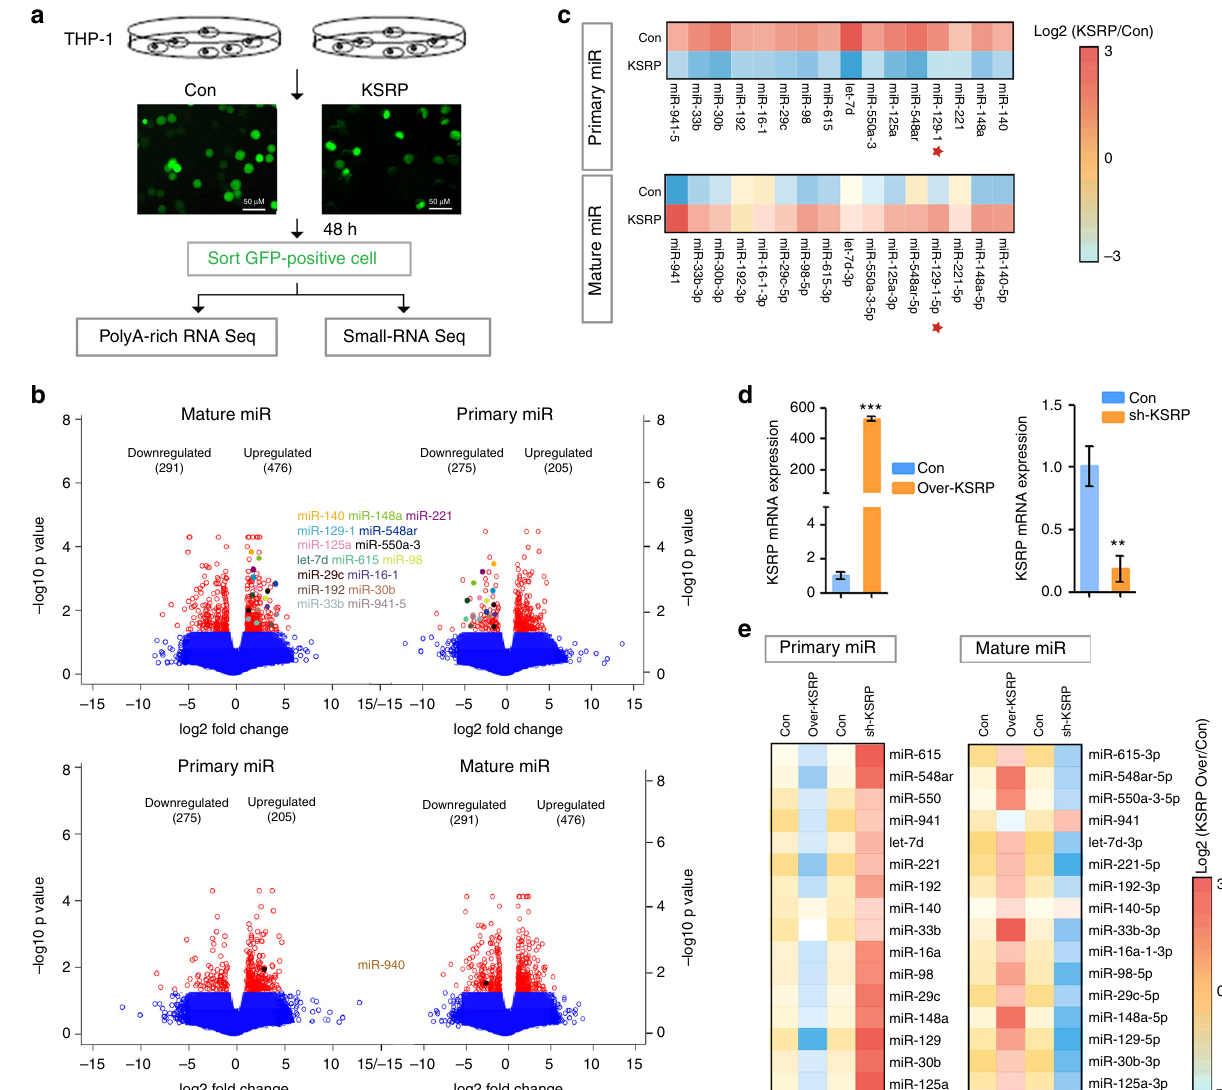
Fig. 3 RNA-seq identi fi es KSRP regulated primary miRNA. a Microscopy images of THP-1 cells transduced with lentiviruses expressing GFP (Con) or KSRP (KSRP). The GFP + cells were subsequently sorted by FACS. The bar represents 50 μ m. b Volcano plots displaying the average log2 ratios of the expression of all pri-miRNAs in poly(A)-enriched RNA-seq data and the expression of mature miRNAs in small RNA-seq data from KSRP versus Con groups obtained in a . miRNA candidates whose processing was either promoted (upper) or inhibited (lower) by KSRP were shown in multi-color. miRNAs with statistically signi fi cant ( p -value < 0.05, pairwise multiple comparisons) are shown in red. c Heat map representation of relative pri-miRNA and mature miRNA expression levels obtained from the RNA-seq data for the 16 selected miRNAs. d , e THP-1 cells in which endogenous KSRP was knocked down or overexpressed were analyzed by qPCR for KSRP expression d or the primary and mature transcripts expression corresponding to the 16 miRNAs e . Three technical replicates from a single experiment. Data are shown as means ± s.d. ** P < 0.01, *** P < 0.001, Student ’ s t